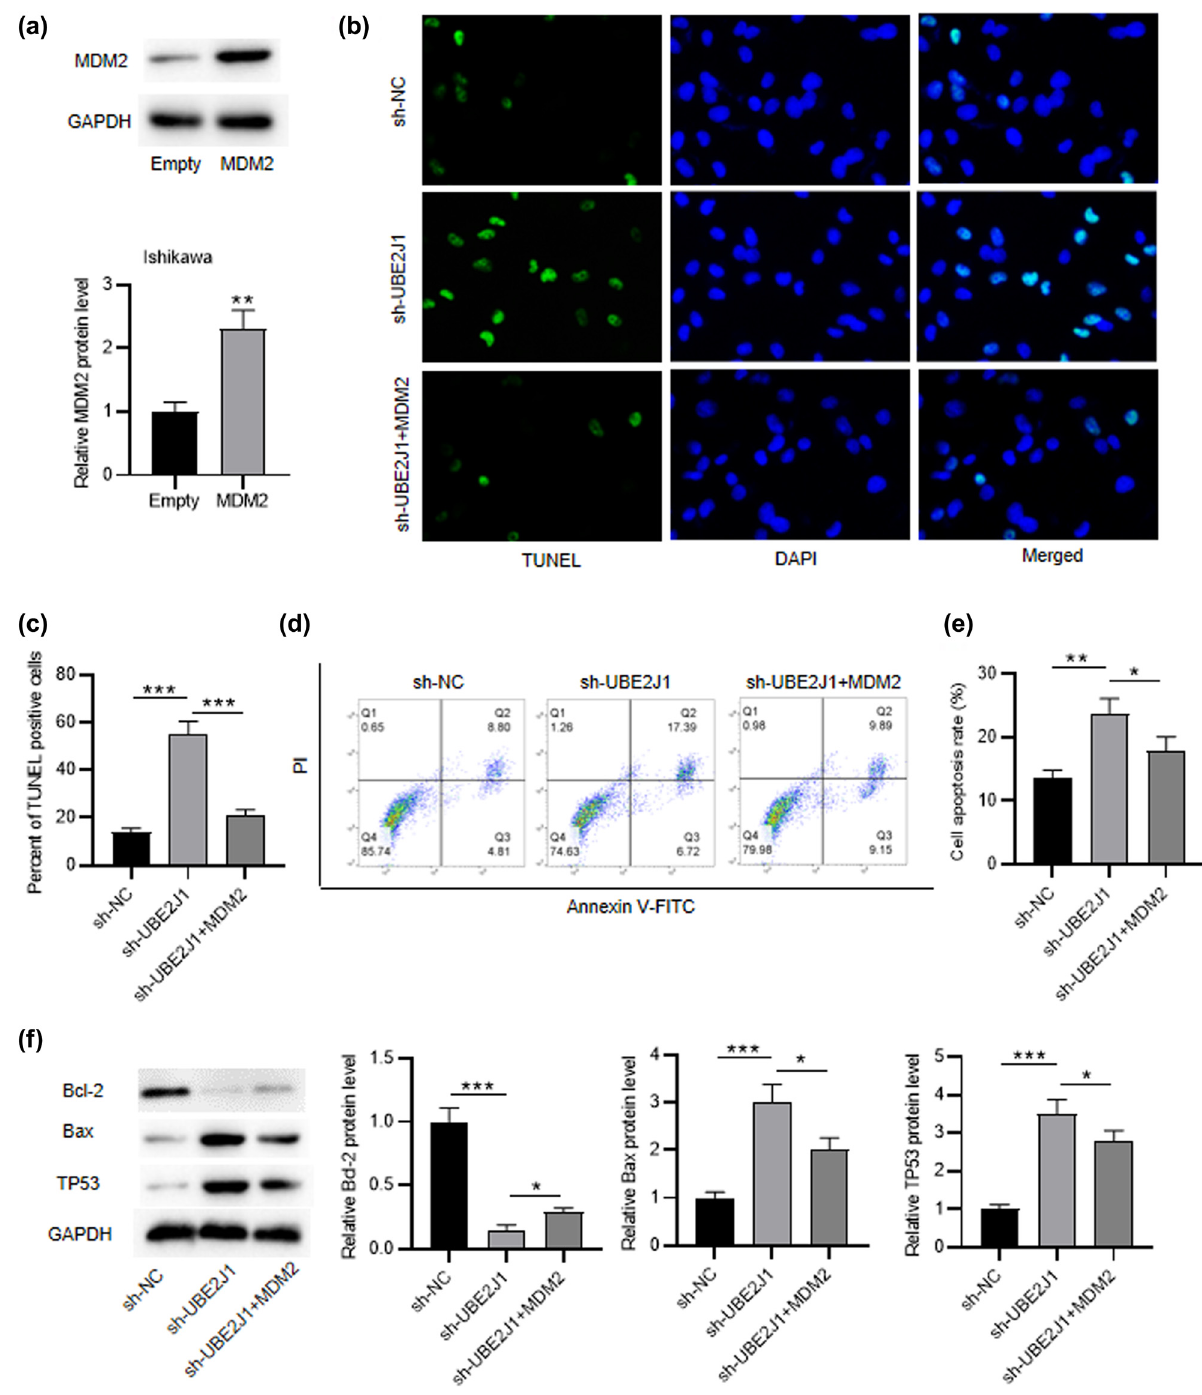
Figure 5: MDM2 overexpression reverses cell apoptosis mediated by UBE2J1 downregulation. ( a ) Overexpression e ffi ciency of pcDNA3.1/ MDM2 in Ishikawa cells was assessed by western blot. ( b and c ) TUNEL assay and ( d and e ) fl ow cytometry analysis were conducted to evaluate the apoptosis of Ishikawa cells transfected with sh - NC, sh - UBE2J1, and sh - UBE2J1 + pcDNA3.1/MDM2. ( f ) Protein levels of Bcl - 2, Bax, and TP53 in Ishikawa cells with the above transfection were analyzed by western blot. Bar graphs were used to represent the data. * p < 0.05, ** p < 0.01, *** p <